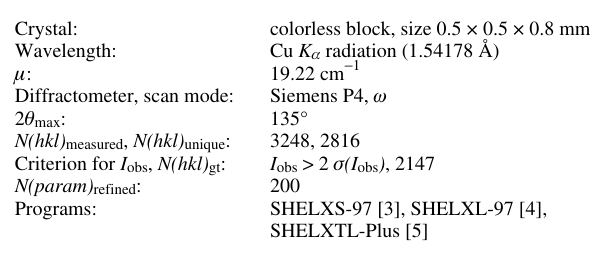
Table 1. Data collection and handling.